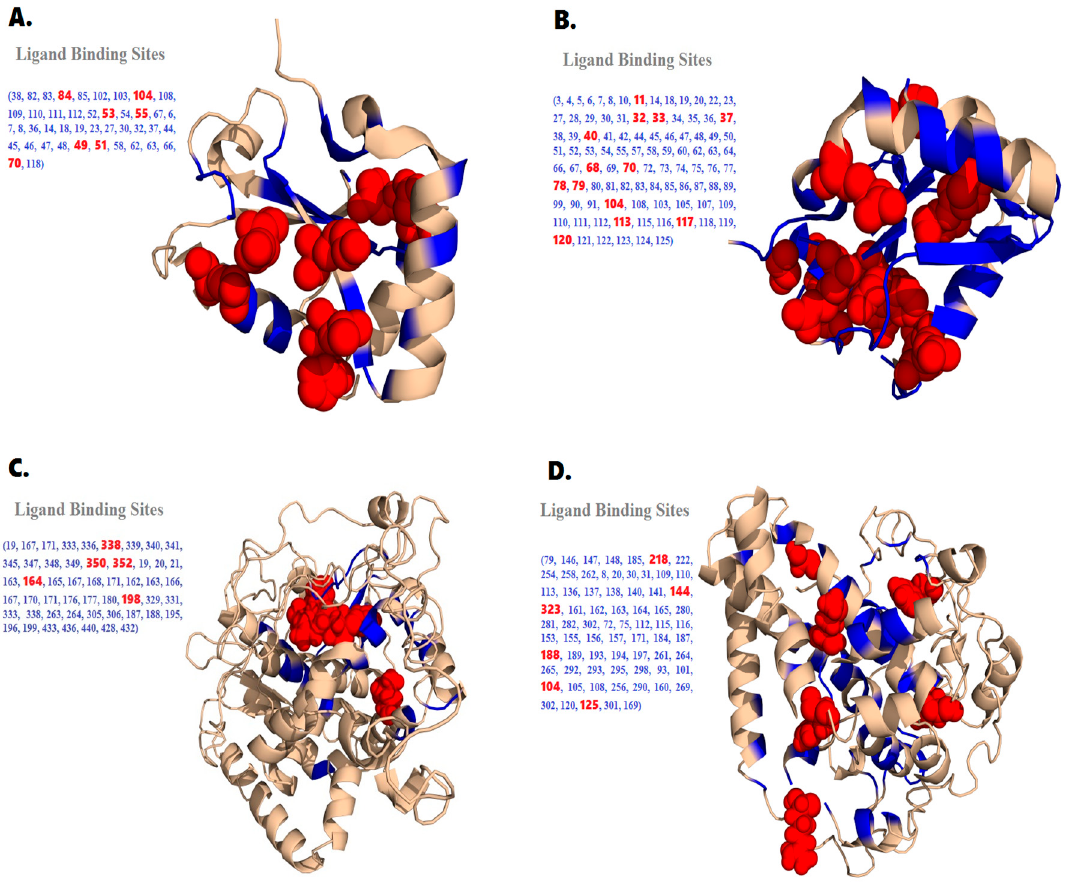
Figure 7. Human LC3A (PDB ID: 4ZDV) ( A ), LC3B (PDB ID: 2ZJD) ( B ), BECN1 ( C ) and SCD1 ( D ) in cartoon and a ball-and-stick representations. Ligand binding pockets were annotated by FTsite and COACH servers. Ligand binding sites coinciding with highly deleterious missense mutations are shown as ball-and-sticks in red color. Illustration was created using PYMOL.